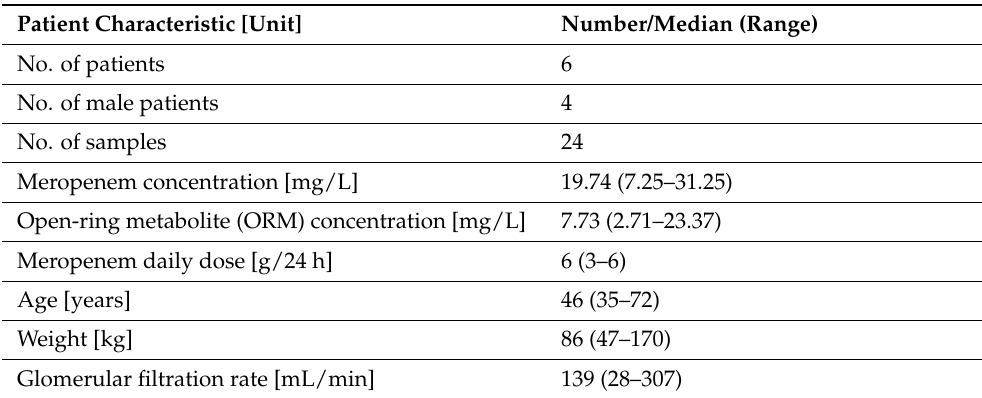
Table 1. Overview of patient characteristics.